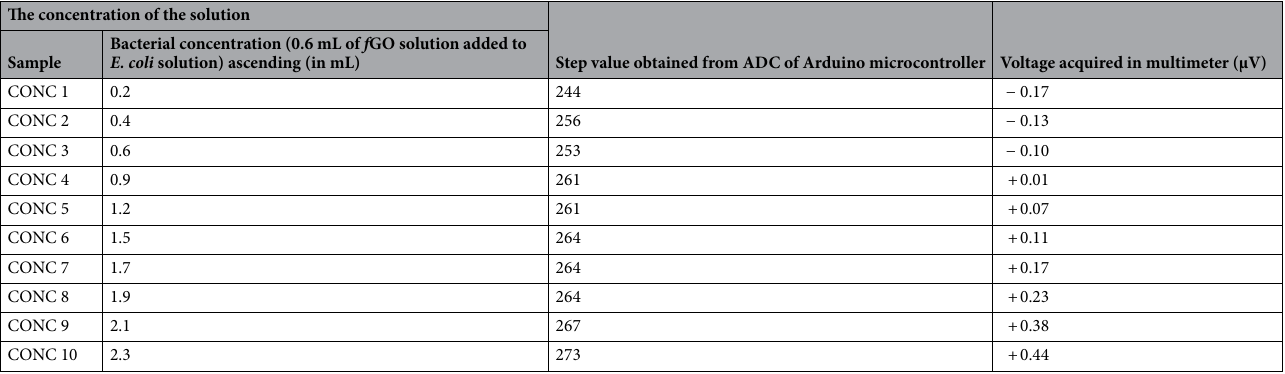
Table 1. Experimental data for various bacterial concentrations.